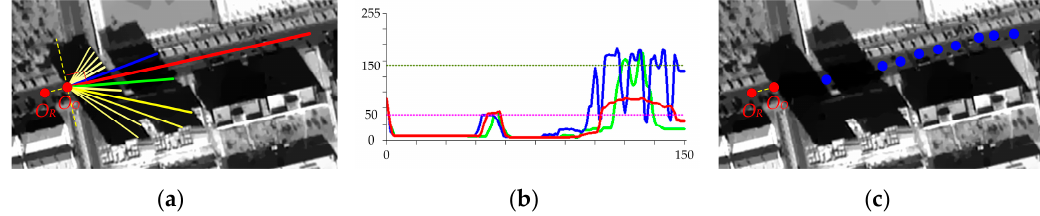
Figure 8. Beamlet descriptor. ( a ) Construction of the multiangle beamlet descriptor; ( b ) gray value change diagram of pixels along the directions of the red, green, and blue lines; ( c ) the results of shadow ‐ crossing.